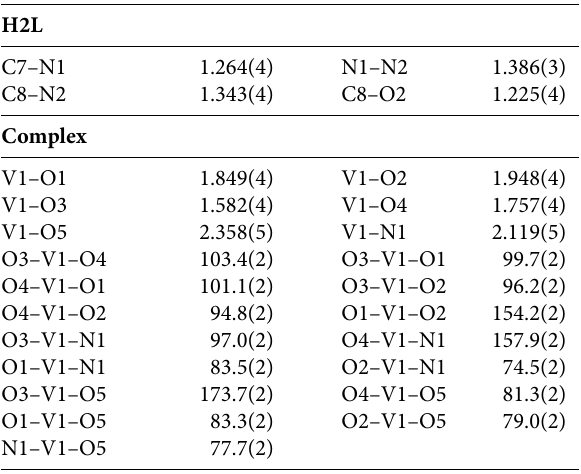
Table 2. Selected Bond Lengths (Å) and Angles (°) for H 2 L and the Complex